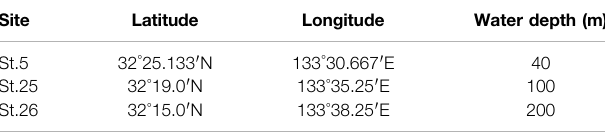
TABLE 1 | Sampling sites in Tosa Bay, southwest